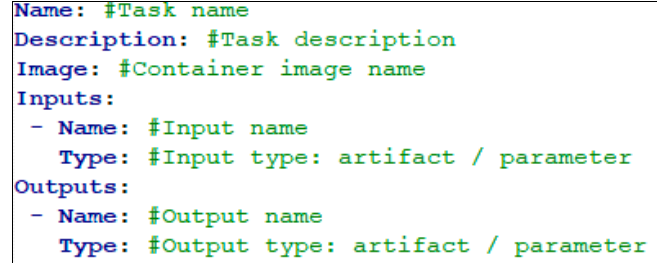
Figure 2. Task definition structure.